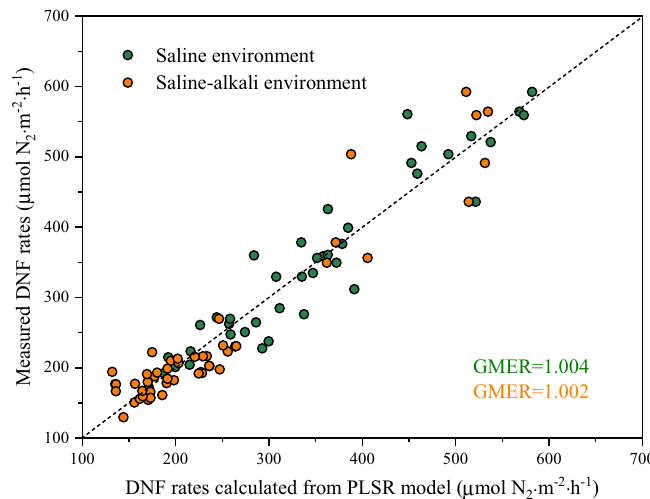
Figure 7. Measured versus calculated denitrification rates based on the PLSR model in the saline and saline- alkali environments. The dotted black line represents a 1:1